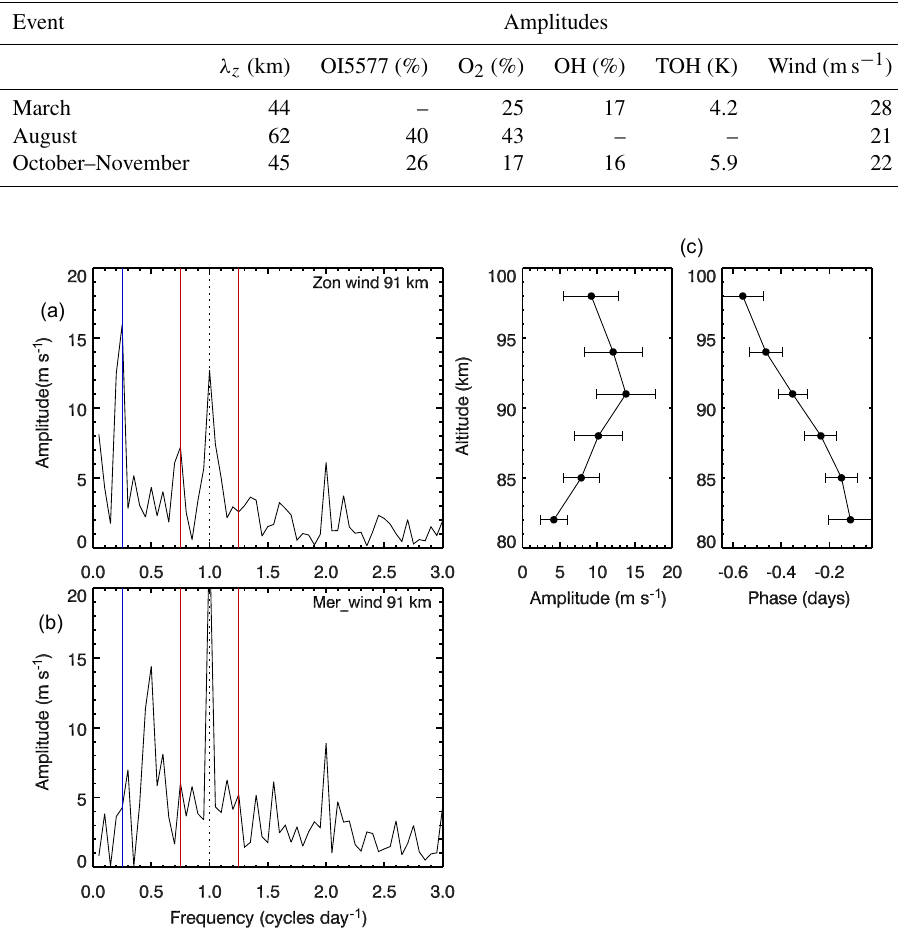
Figure 8. Fourier amplitude spectrum of the zonal (a) and meridional (b) wind between days 60 and 75 of 2005 and vertical structure of amplitude and phase of the 0.75 cyclesday − 1 secondary wave in the zonal wind (c)